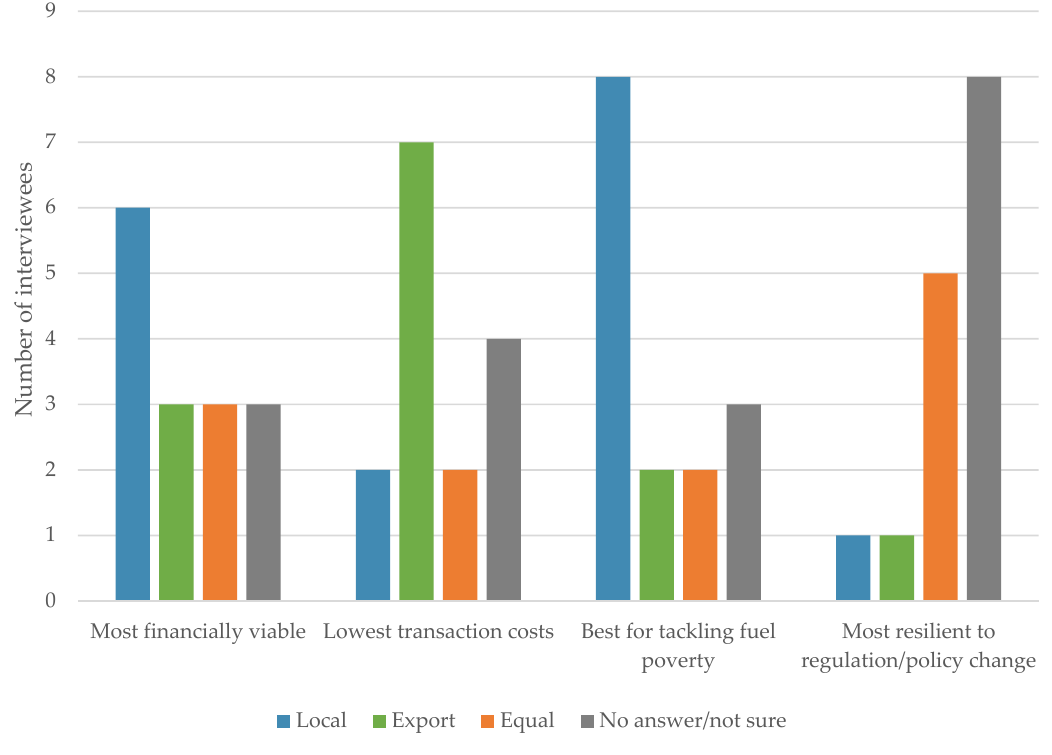
Figure 3. Interviewee responses to questions 2a–d comparing ‘local’ and ‘export’ models.